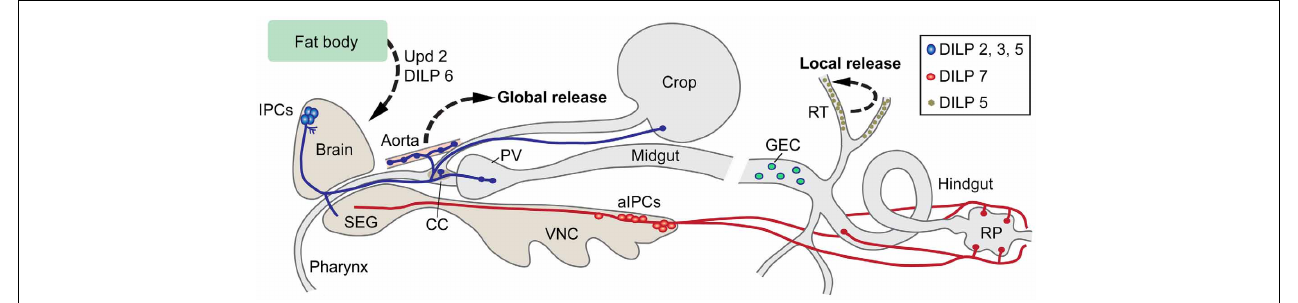
FIGURE 1 | Insulin-producing cells (IPCs) in the Drosophila nervous system and gut. A set of 14 IPCs (blue) in pars intercerebralis of the brain send axons to the tritocerebrum (adjacent to the subesophageal ganglion, SEG), to the corpora cardiaca (CC) with associated aorta, proventriculus (PV), and the crop. Likely release sites for circulating Drosophila insulin-like peptides (DILPs) are in CC, aorta, PV, and crop. These IPCs produce DILP2, 3, and 5. The branches in protocerebrum (near cell bodies) and tritocerebrum of the brain could be dendritic and/or represent further release sites. A second set of 20 cells (aIPCs; red) is found in the abdominal neuromeres of the ventral nerve cord (VNC). These produce DILP7 and supply axon terminations to the hindgut including the rectal